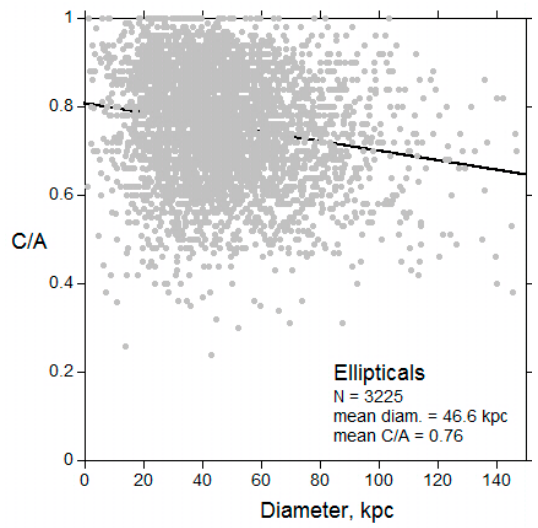
Figure 10. Dependence of the axial ratio on ellipticals in the NED database [42]. The number of samples is lower than that in Figure 8 because all types that were not labeled as E, E1, etc. are excluded. Please note that the mean values were unchanged during the culling.